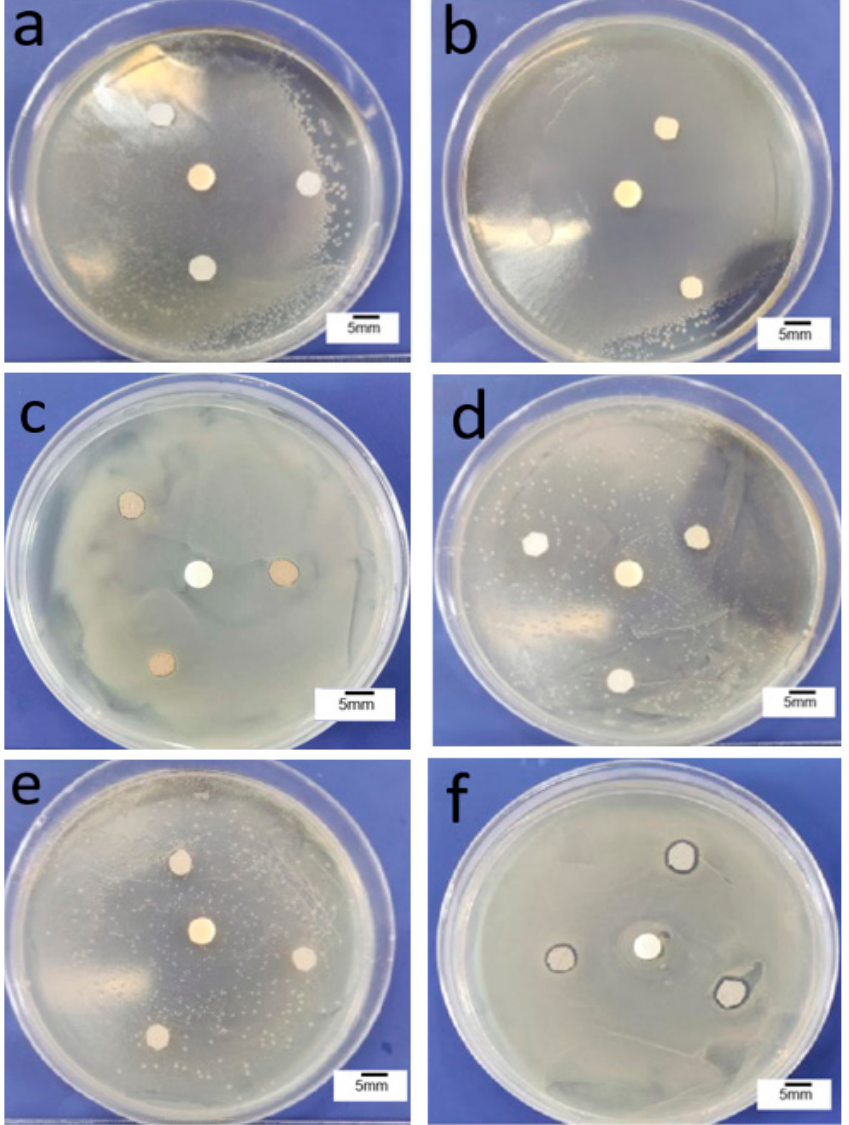
Figure 8. ( a – c ) E. coli antimicrobial results of SF/GEL, SF/GEL/KA-N, and SF/GEL/KA-N/AgNWs fi lms, respectively. ( d – f ) S. aureus antimicrobial results of SF/GEL, SF/GEL/KA-N, and SF/GEL/KA-N/AgNWs fi lms.